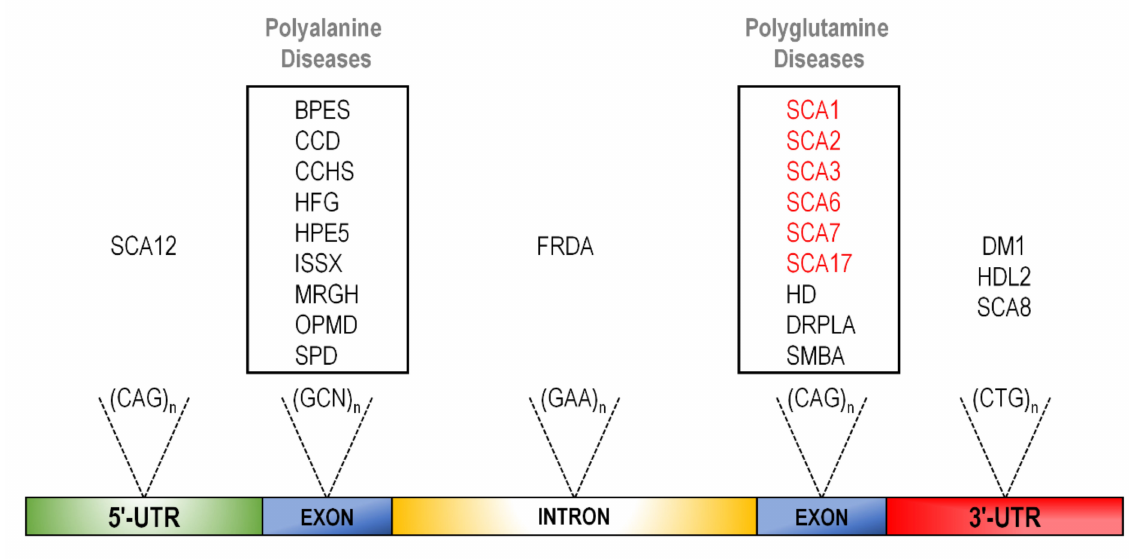
Figure 1. Relative pre-mRNA locations of tri-nucleotide expansions causing human disease. Type of expanded trin- ucleotides found in respective locations are shown above the transcript: SCA12 = spinocerebellar ataxia type 12; BPES = blepharophimosis, ptosis and epicanthus inversus; CCD = cleidocranial dysplasia; CCHS = congenital central hypoventilation; HFG = hand–foot–genital syndrome; HPE5 = holoprosencephaly 5; ISSX = X-linked infantile syndrome; MRGH = mental retardation with isolated growth hormone deficiency; OPMD = oculopharyngeal muscular dystrophy; SPD = synpolydactyly. Intron: GAA repeat: FRDA = Friedreich’s ataxia; SCA1, 2, 3, 6, 7, 17 = spinocerebellar ataxia type 1, 2, 3, 6, 7, 17; HD = Huntington’s disease; DRPLA = dentatorubral–pallidoluysian atrophy; SMBA = spinal and bulbar muscular atrophy;DM1 = myotonic dystrophy type 1; HDL2 = Huntington’s-disease-like 2; SCA8 = spinocerebellar ataxia type 8. Polyglutamine ataxias are in